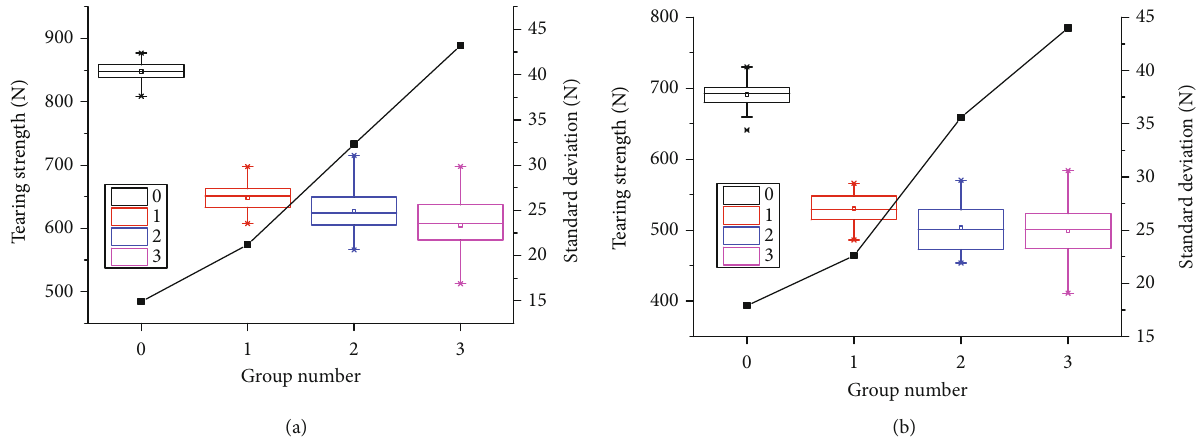
Figure 8: Box plots of tearing strength and the standard deviation of each group of test data: (a) test data in warp direction and (b) test data in weft